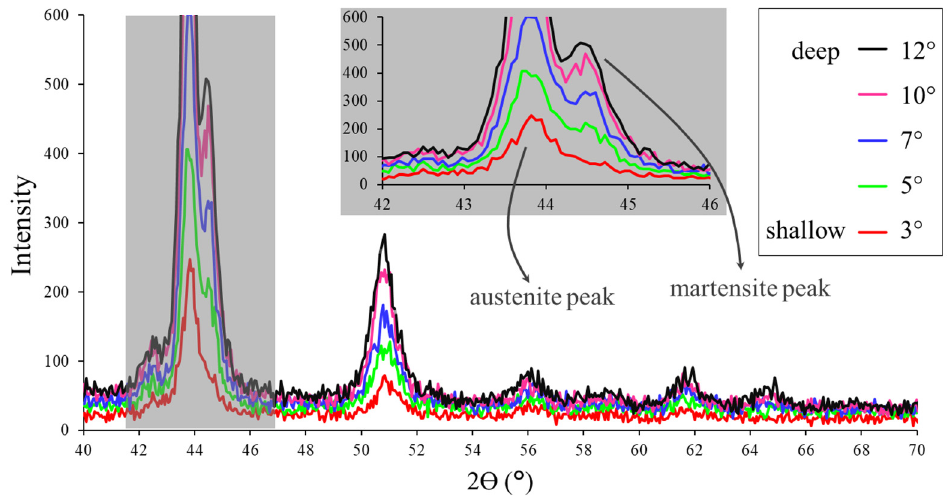
Figure 5. GIXRD profiles of intermediate layer at z direction varying incidence angles from 3° (shallow) to 12° (deeper). There is austenite peak for the shallowest angle (3° curve) and peaks of austenite and martensite for greater angles (deeper penetration in the sample).